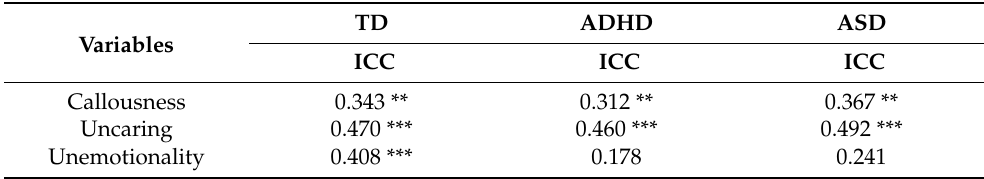
Table 3. Correlation Between Parent-Reported and Adolescent-Reported Callous–Unemotional Traits Among TD, ADHD, and ASD Groups: Pearson’s Correlation.